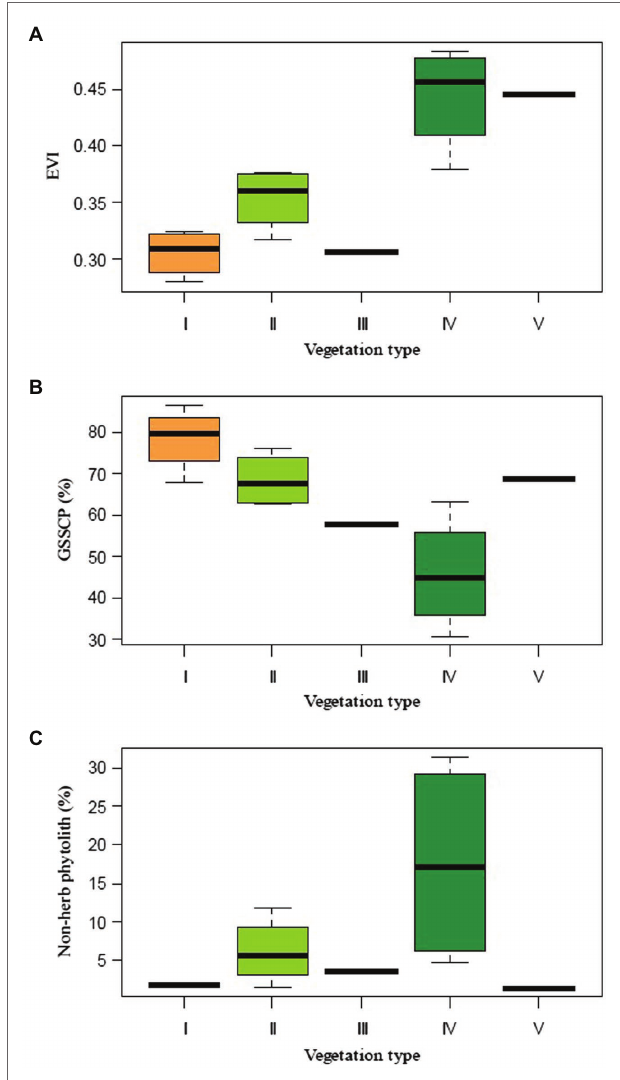
FIGURE 8 | Summary of different vegetation index and phytolith percentages for different plant communities collected along the elevation gradient in the Daiyun Mountains. (A) Enhanced vegetation index (EVI); (B) Grass silica short cell phytolith (GSSCP); and (C) Non-herb phytolith